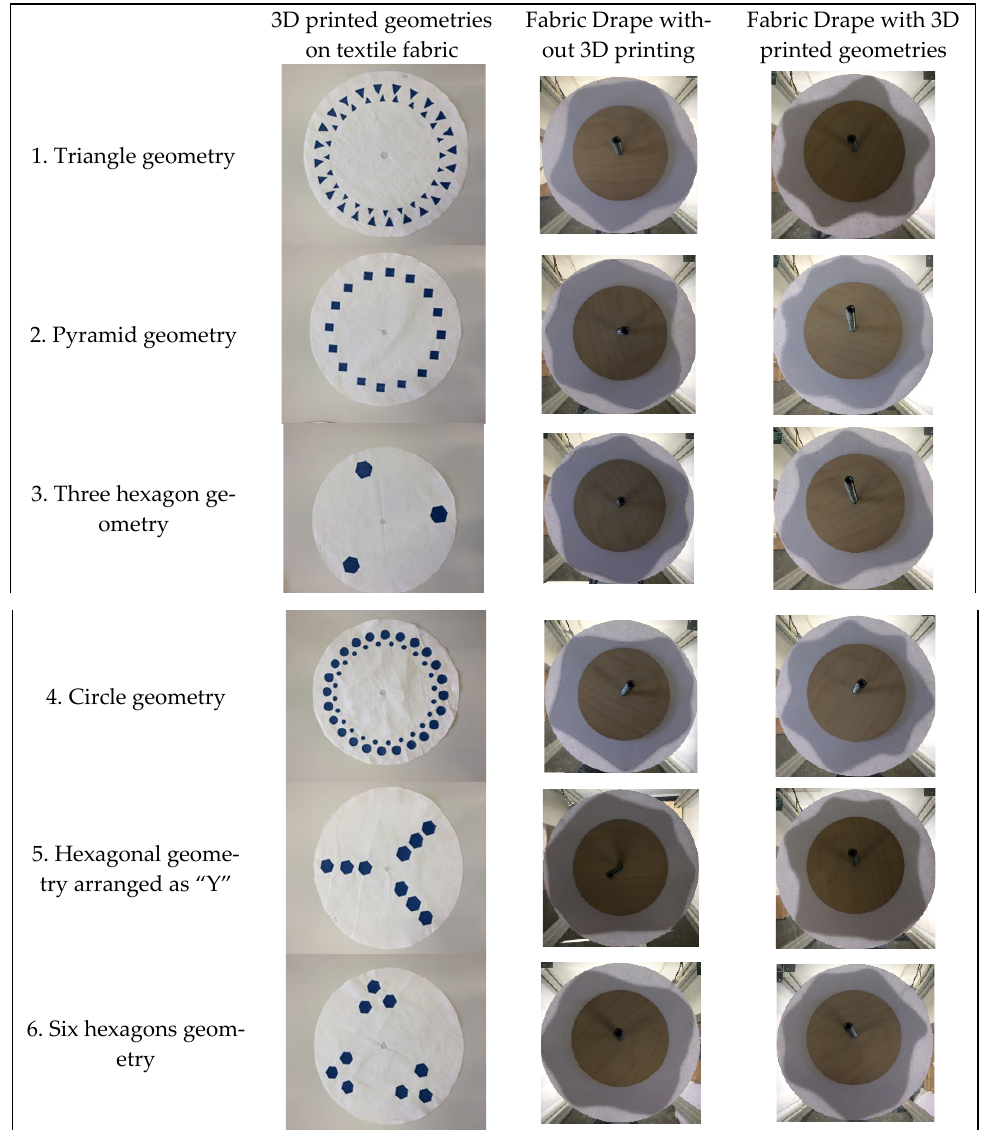
Figure 5. The 3D printing geometry on textile fabric—general view.